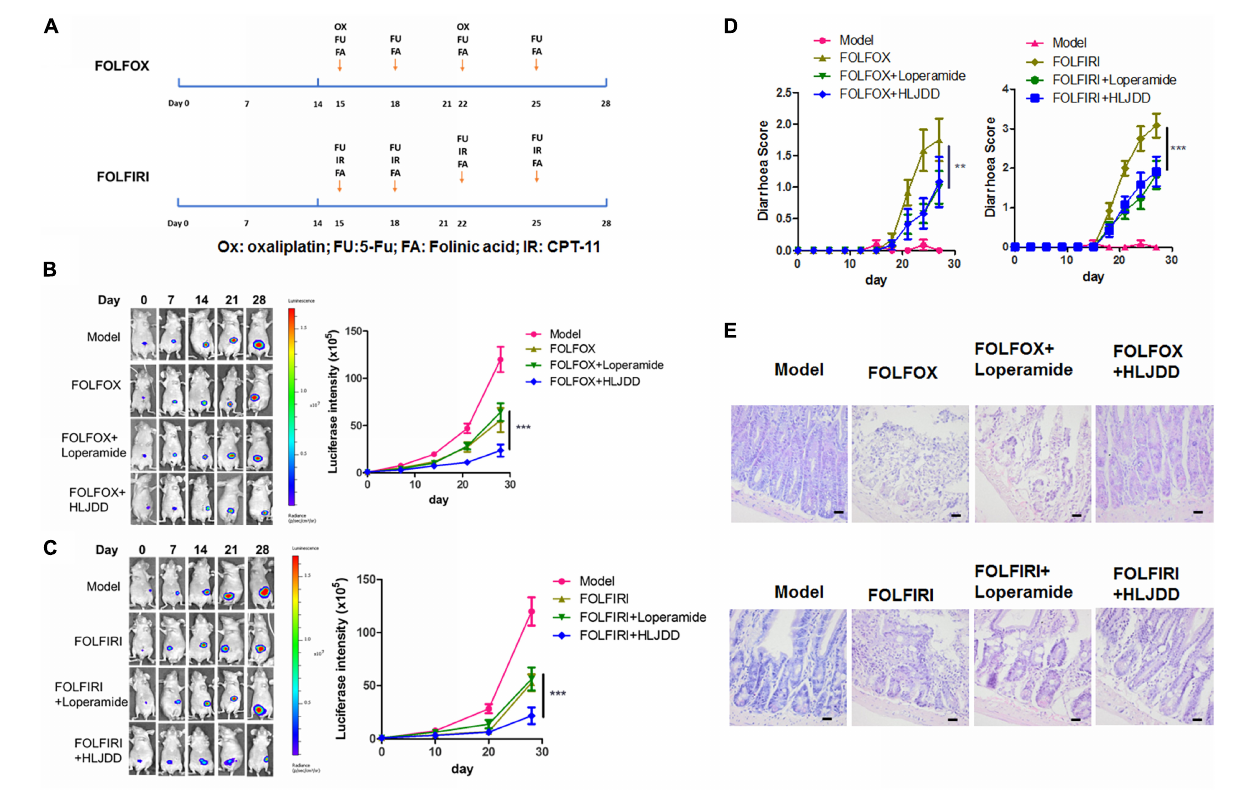
FIGURE 6 | Pre-treatment of HLJDD improved tumor response and diarrhea in clinical chemotherapy regimens FOLFOX- and FOLFIRI-treated colon cancer in mice. (A) Showed the regimen plan of FOLFOX and FOLFIRI; (B,C) showed that 2-week pretreatment of HLJDD at 200 mg/kg could significantly potentiate the tumor suppressive effect FOLFOX and FOLFIRI on orthotopic colon cancer; (D) showed that 2-week pretreatment of HLJDD at 200 mg/kg could significantly improve the diarrhea induced by FOLFOX and FOLFIRI; (E) showed that 2-week pretreatment of HLJDD at 200 mg/kg could improve the histological structure of jejunum in FOLFOX- and FOLFIRI-treated colon cancer in mice. ** p < 0.01, *** p < 0.001 when compared with the respective chemotherapy regimen group.